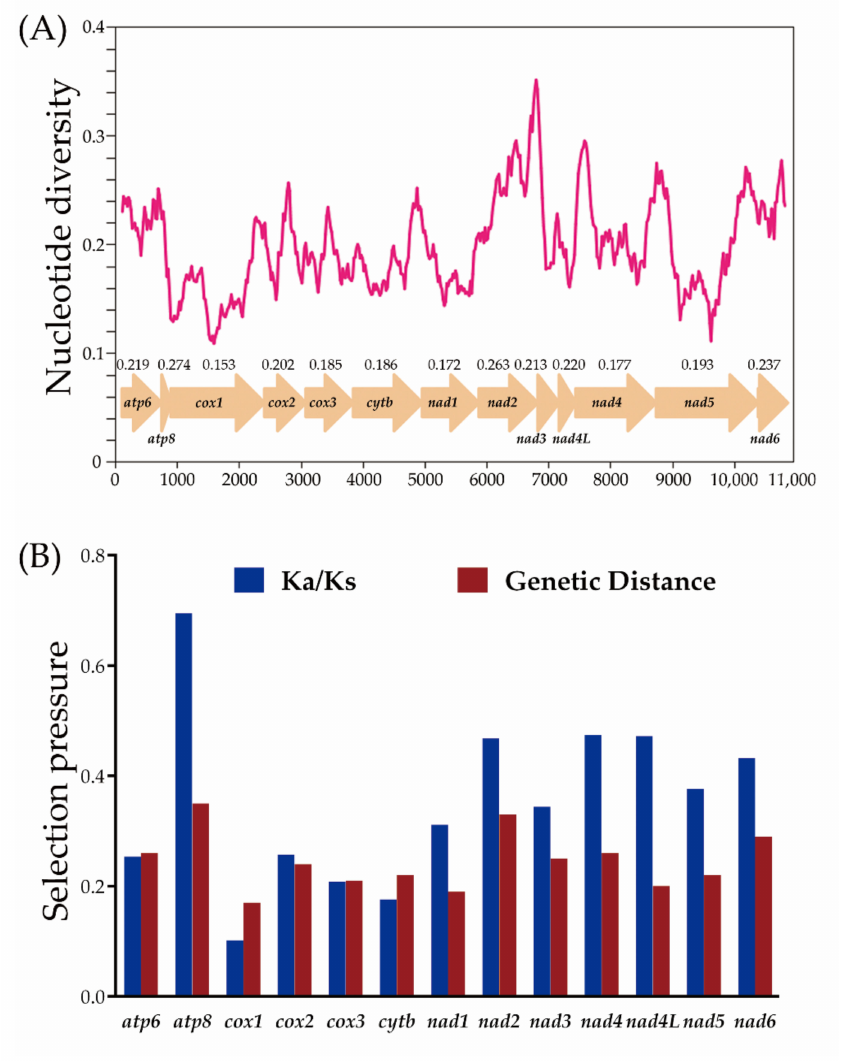
Figure 7. Nucleotide diversity and selection pressures on 13 PCGs in Mileewinae. ( A ) Sliding window analysis of 13 protein-coding genes among six Mileewinae species. The red curve shows the value of Pi (nucleotide diversity). Pi value of each PCG is shown above the arrows. ( B ) Genetic distances (on average) and ratio of non-synonymous (Ka) to synonymous (Ks) substitution rates of each protein-coding gene among six Mileewinae